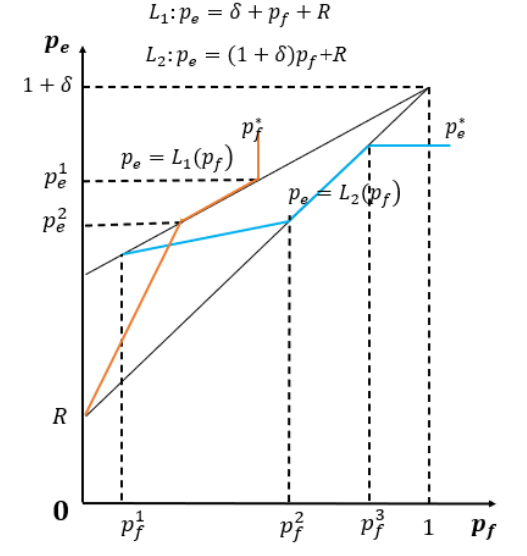
Figure A2. Best response